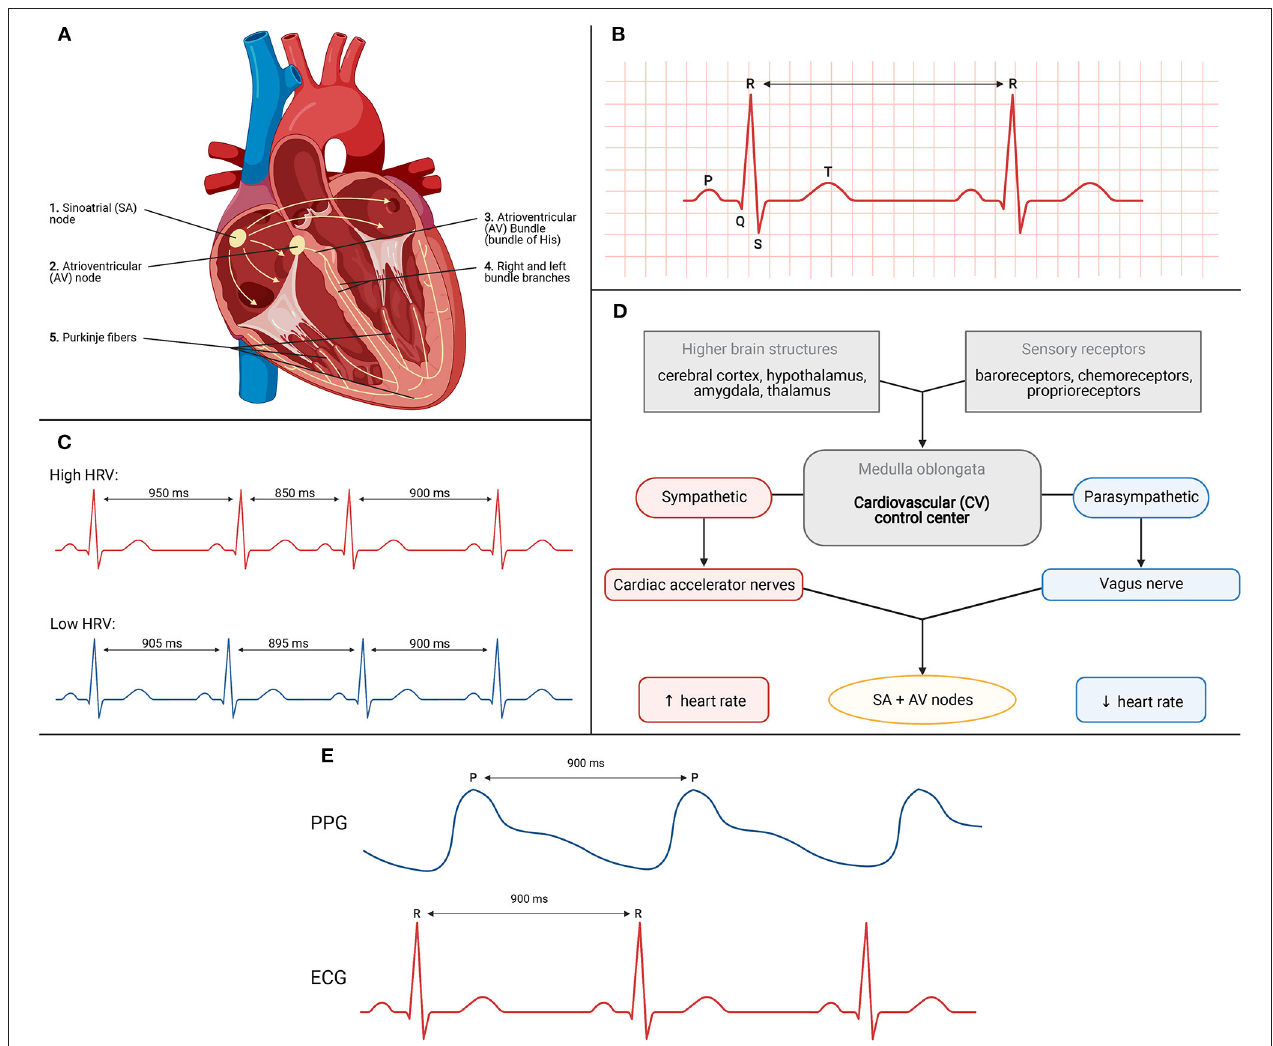
FIGURE 4 | (A) Conduction system of the heart. (B) Schematic for ECG recording of electrical activity. (C) High vs. low heart rate variability (HRV). (D) Schematic depicting various factors influencing HR and HRV. (E) Correlation between R-R interval from ECG trace to P-P interval from PPG